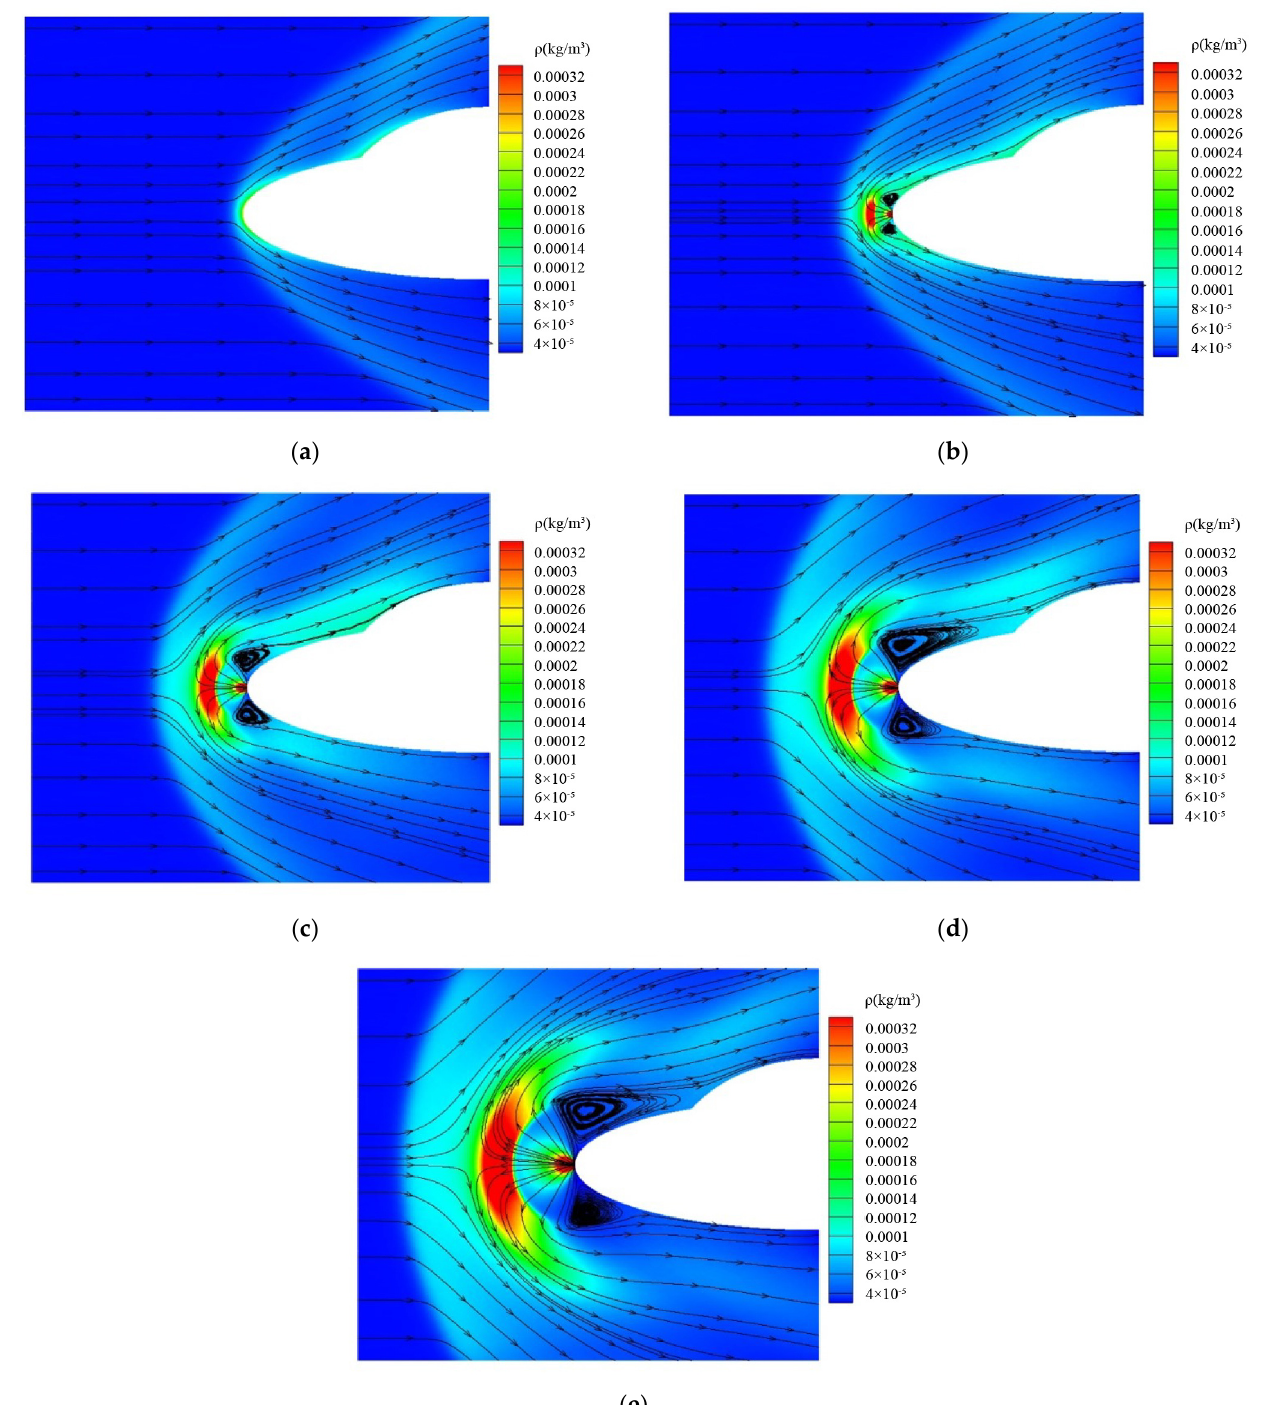
Figure 10. Contours of density distribution and streamline around the double ellipsoid opposing jet: ( a ) No opposing jet; ( b ) PR = 0.2; ( c ) PR = 0.4; ( d ) PR = 0.6; ( e ) PR = 0.8.